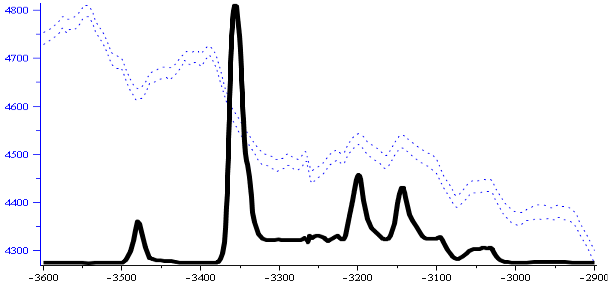
Fig. 5. An idealized calibration curve, with one measurement for each calendar year and ages exactly 120, 110, 100, 90, and 80 14